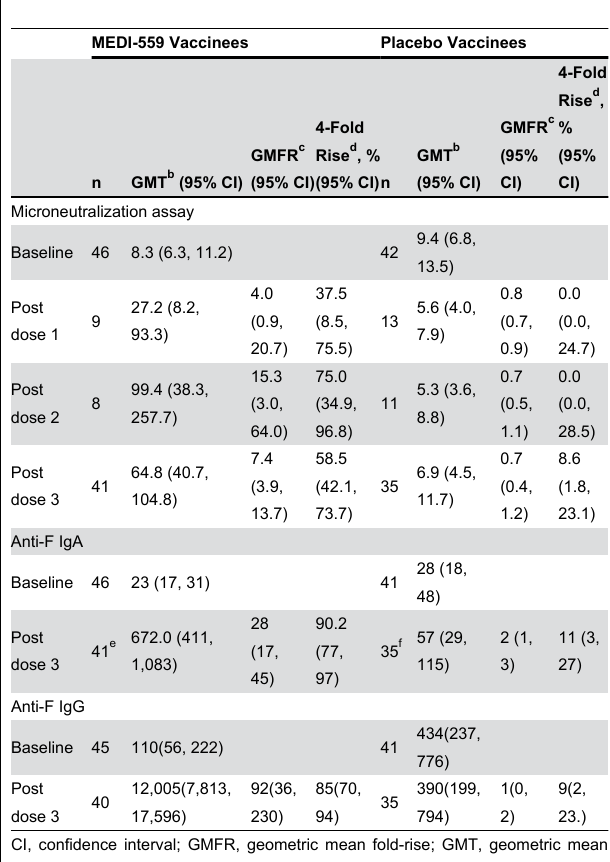
Table 4. GMTs, GMFRs, and seroresponse in neutralizing serum antibodies against RSV a